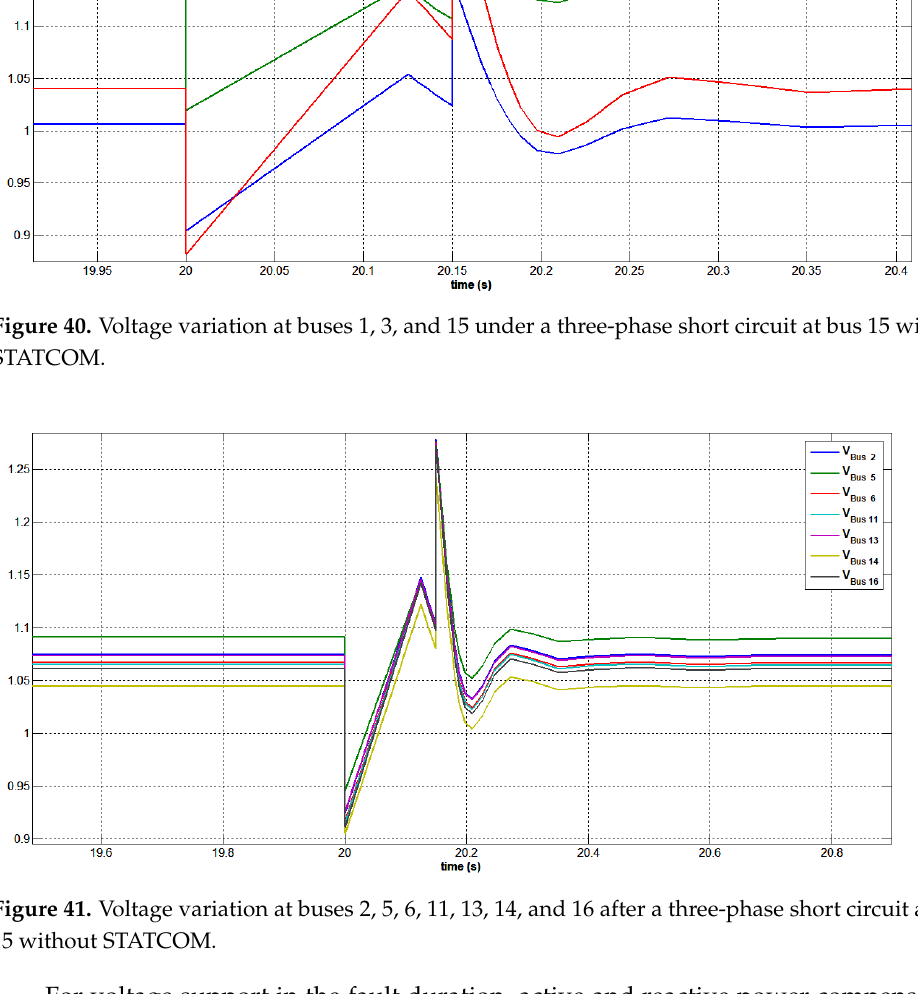
Figure 41. Voltage variation at buses 2, 5, 6, 11, 13, 14, and 16 after a three ‐ phase short circuit at bus 15 without STATCOM.